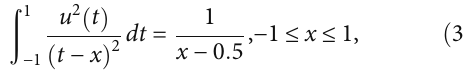
Figure 5: The graph of approximate solutions u